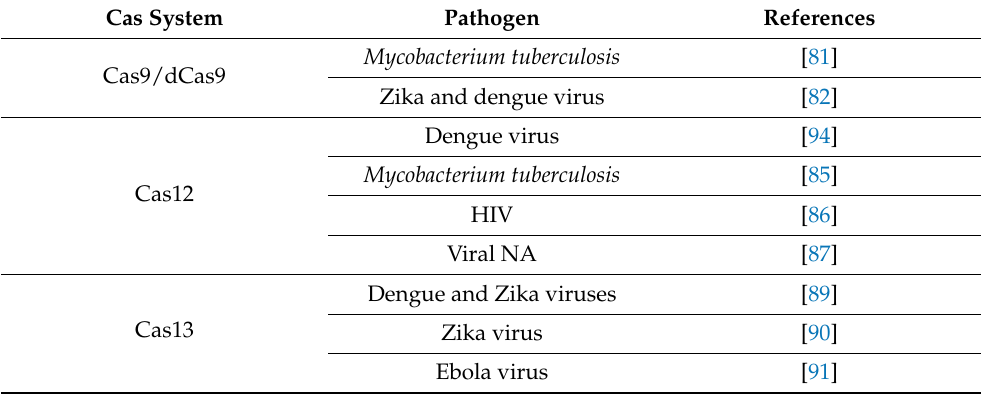
Table 3. Detection of tropical diseases using the CRISPR/Cas